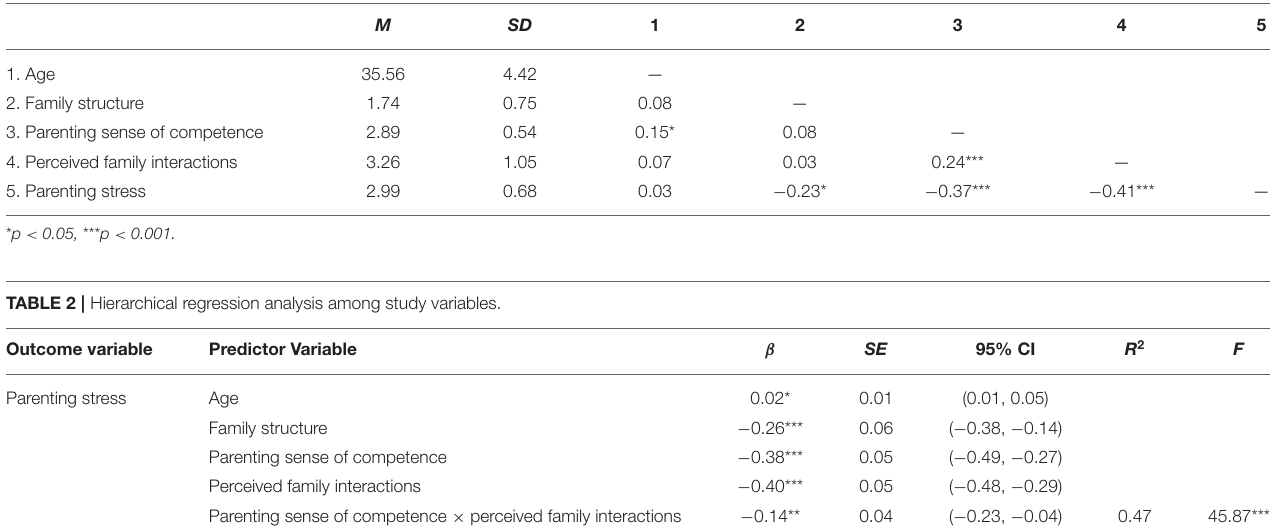
TABLE 1 | Description statistics and zero-order correlation of the constructs.